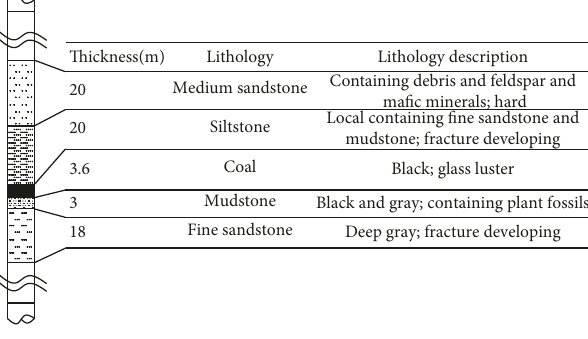
Figure 11: Strata geological